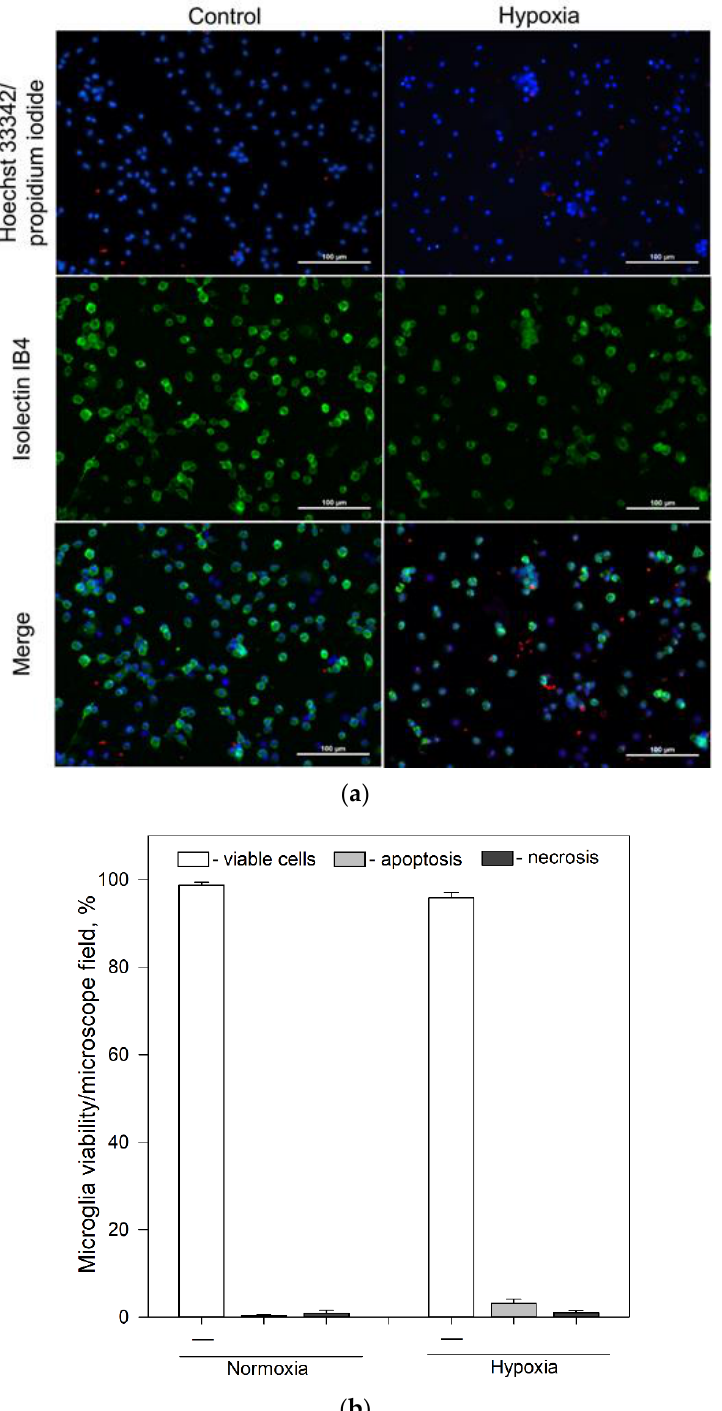
Figure 1. Effect of hypoxia on microglial viability after 24 h incubation. ( a ) Typical fluorescence microscopy images of cultures of microglia under normoxic and hypoxic conditions after 24 h incubation: upper line—control group (normoxia); lower line—microglia after 24 h incubation under hypoxic conditions. First column—cell nuclei labelled with